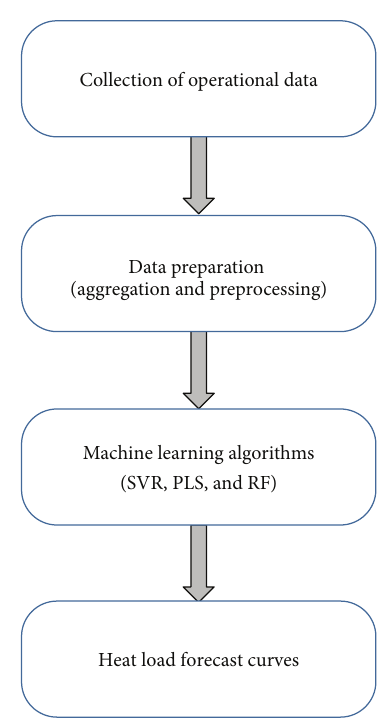
Figure 2: Workflow scenario of the proposed heat load